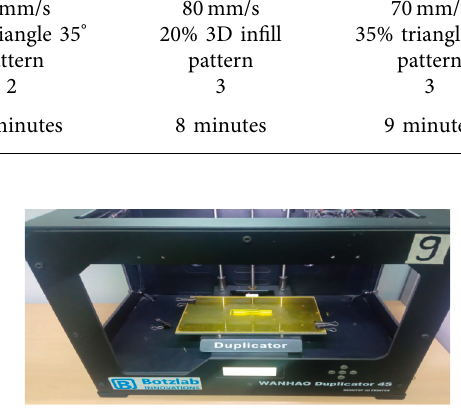
Figure 3: Printed tensile